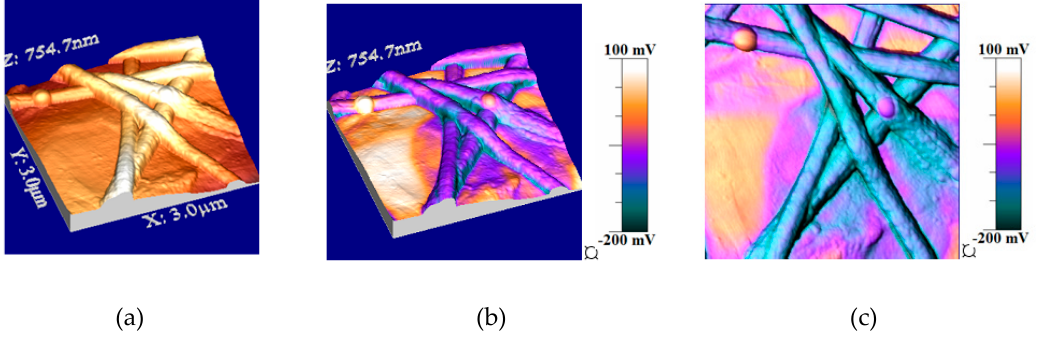
Figure 2. P(VDF-TrFE) / Graphene oxide composite fibers. ( a ) 3D topography image, ( b , c ) Topography with Kelvin Probe Force Microscopy (KPFM) image (surface potential) over-imposed (colored coded). The topography is mapped onto the third dimension (z-axis) and the recorded surface potential is color-coded; ( b ) 3D side view; ( c ) 3D top view.